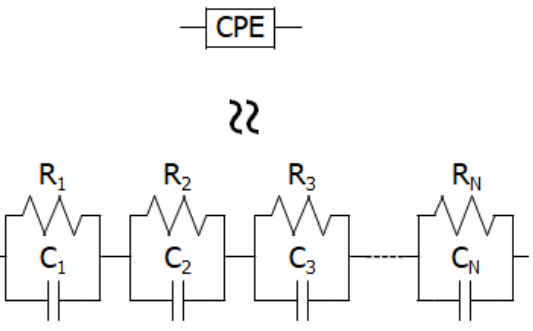
Figure 4. Approximation of a CPE by the series connection of N RC